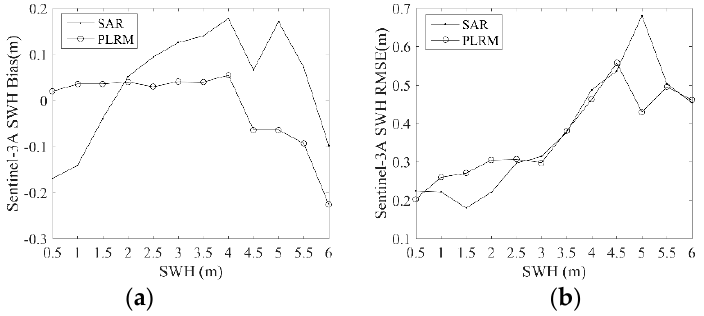
Figure 11. Dependence of ( a ) bias and ( b ) RMSE of Sentinel-3A SWH on buoy wave height.